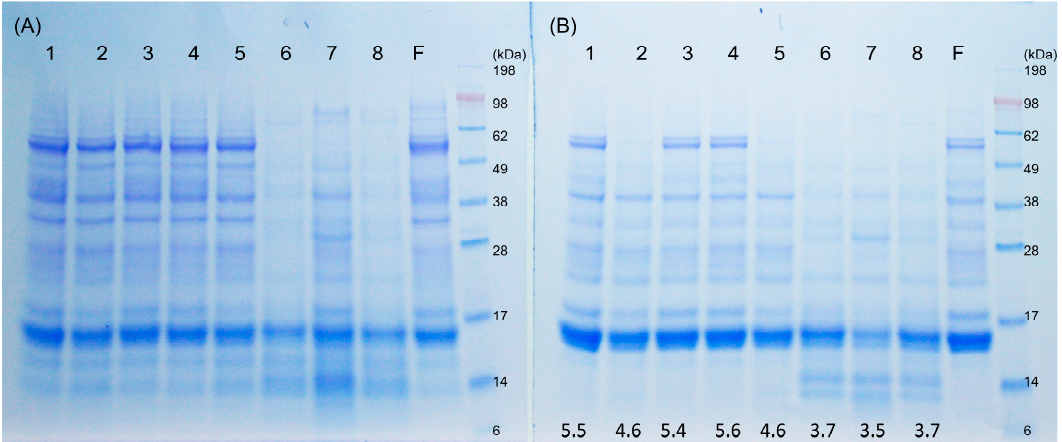
Figure 1. Sodium dodecyl sulfate–polyacrylamide gel electrophoresis (SDS-PAGE) under reducing condition of ( A ) the albumin / globulin extract of yeast-fermented doughs and sourdoughs, and ( B ) albumin / globulin extract of yeast-fermented doughs and sourdoughs after heat treatment. The pH value after fermentation is indicated below. Dough 1, yeast-fermented dough at 30 ◦ C for 1 h; 2, yeast-fermented dough at 30 ◦ C for 17 h; 3, yeast-fermented dough at 4 ◦ C for 17 h; 4, yeast-fermented dough with glutathione at 30 ◦ C for 1 h; 5, yeast-fermented dough with glutathione at 30 ◦ C for 17 h; 6, chemically acidified dough, pH 3.5, at 30 ◦ C for 17 h; 7, wheat sourdough at 30 ◦ C for 17 h; 8, chemically acidified dough, pH 3.5, with glutathione at 30 ◦ C for 17 h; F, wheat flour. The α -amylase / trypsin inhibitor (ATI) proteins migrate in the range of molecular weight 12–15 kDa.